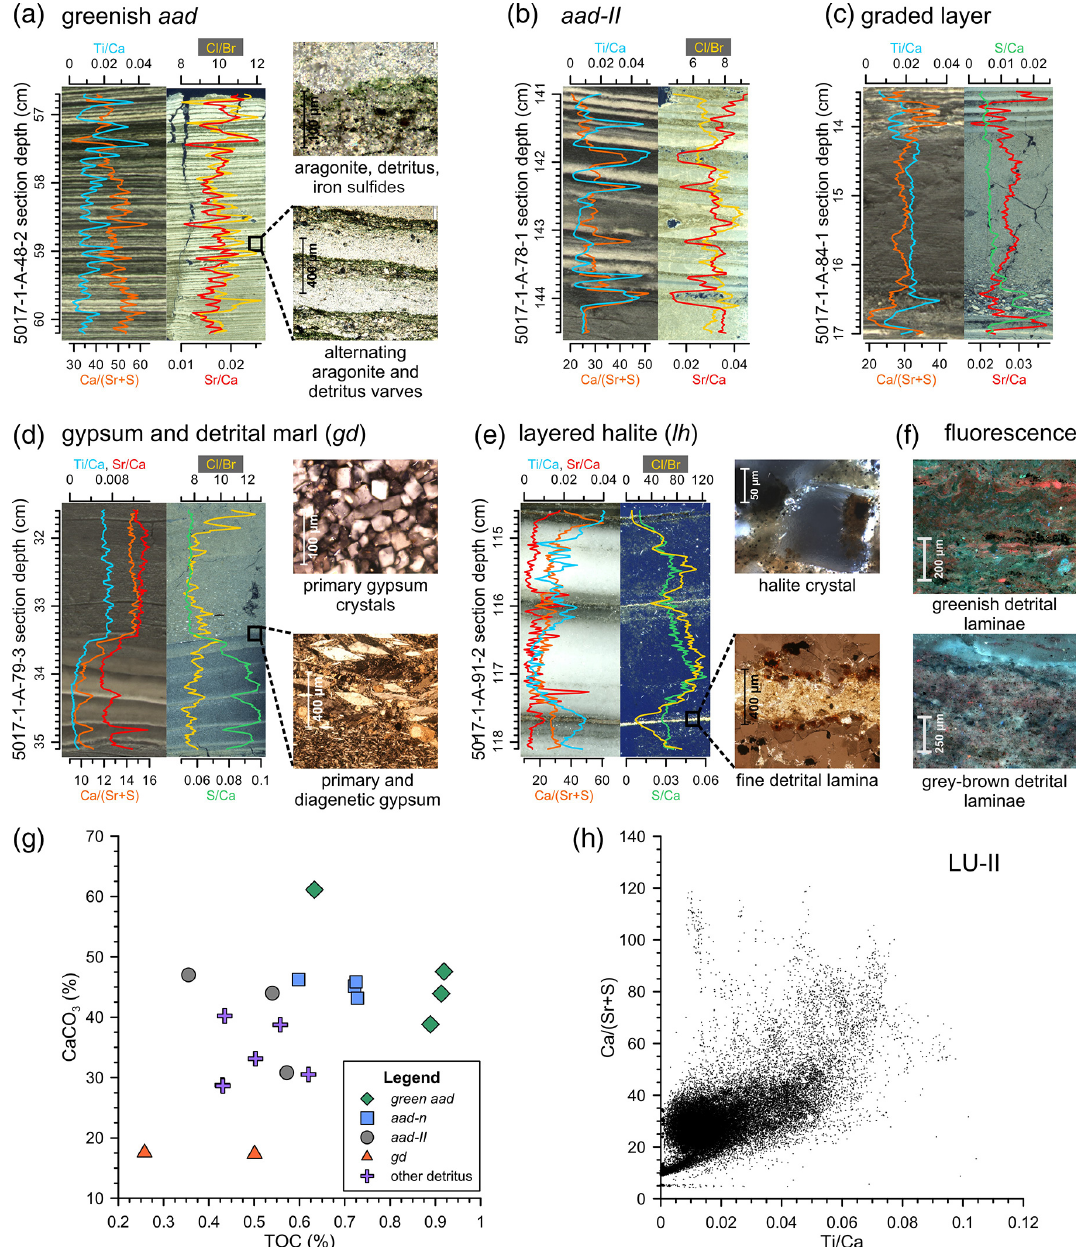
Figure 2. Micro-facies (core photos, polarised thin-section scans and microscopic images with varying magnification and polarisation conditions) and µXRF characteristics (element ratios): (a) green aad facies with peaks in Sr / Ca typical for aragonite layers and peaks in Ti / Ca and Ca / (Sr + S) indicating detrital layers; (b) aad-II facies containing greyish detritus and thicker aragonite layers than the green aad facies; (c) example of a mass-waste deposit: graded layer with high Ti / Ca ratio and increased S / Ca at the base due to diagenetic gypsum; (d) gd facies characterised by a high S / Ca ratio; (e) lh facies with high Cl / Br and positively correlated S / Ca, but peaks of all other elements only in the thin detrital laminae; (f) fluorescence (violet light) microscope images of greenish detrital laminae (upper photo, core section 5017-A-1-87-1, at ∼ 72cm) with very strong fluorescence (red colour) and greyish-brownish detrital laminae (lower photo, core section 5017-1-A-78-1, at ∼ 140cm) that are characterised by a weaker fluorescence; (g) correlation plot of TOC against CaCO 3 contents of 19 samples distinguished for different micro-facies types; (h) correlation plot of the two detrital fractions as derived from µXRF element scanning, exemplary for lithological unit (LU) II: Ti / Ca as proxy for the siliciclastic detrital fraction and Ca / (Sr + S) as proxy for the detrital carbonate fraction, R 2 =